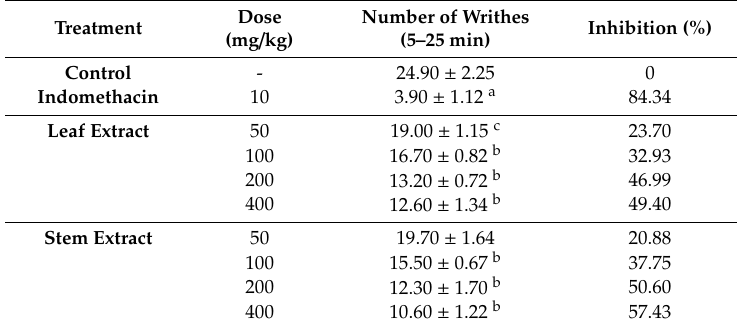
Table 4. E ff ect of leaf and stem extracts of U. bojeri on nociceptive responses in the acetic acid-induced writhing